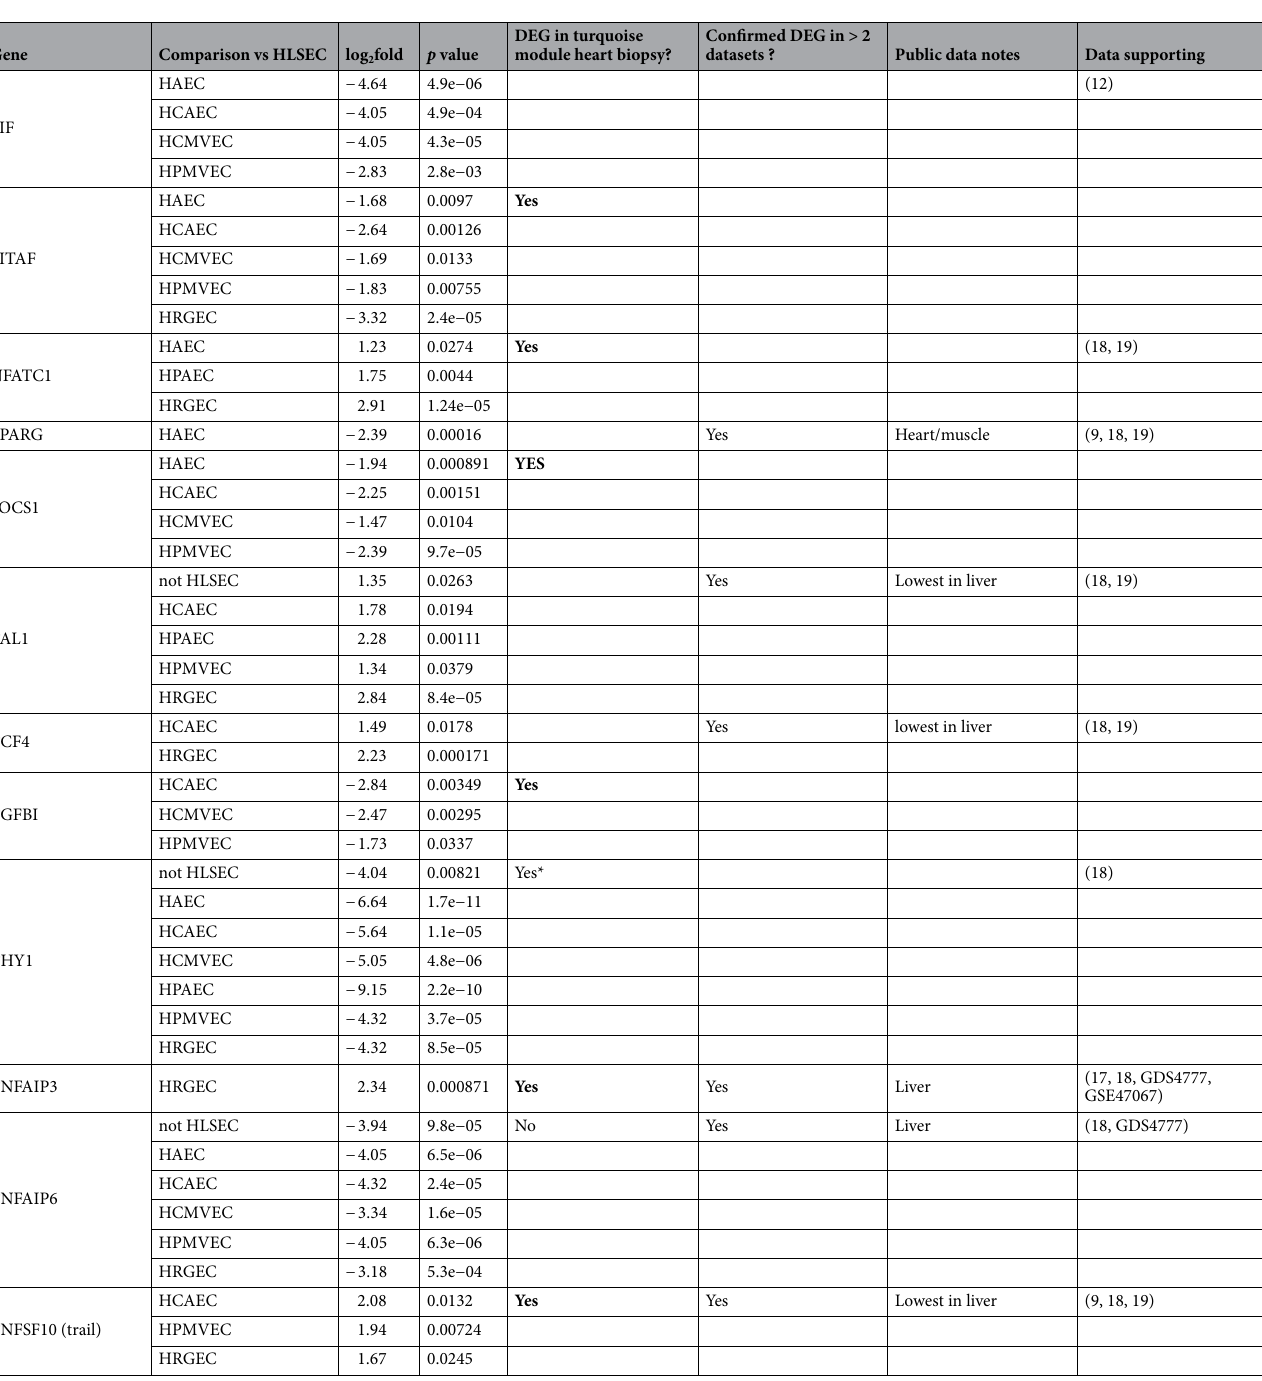
Table 2. List of differentially expressed genes among human endothelial cells from different anatomic origins, and results of confirmatory analysis in public datasets of endothelial cell heterogeneity. *Indicates enrichment may not be due to Endothelial cells, as gene may likely be expressed within leukocyte compartment. "Yes" in bold indicates gene may be